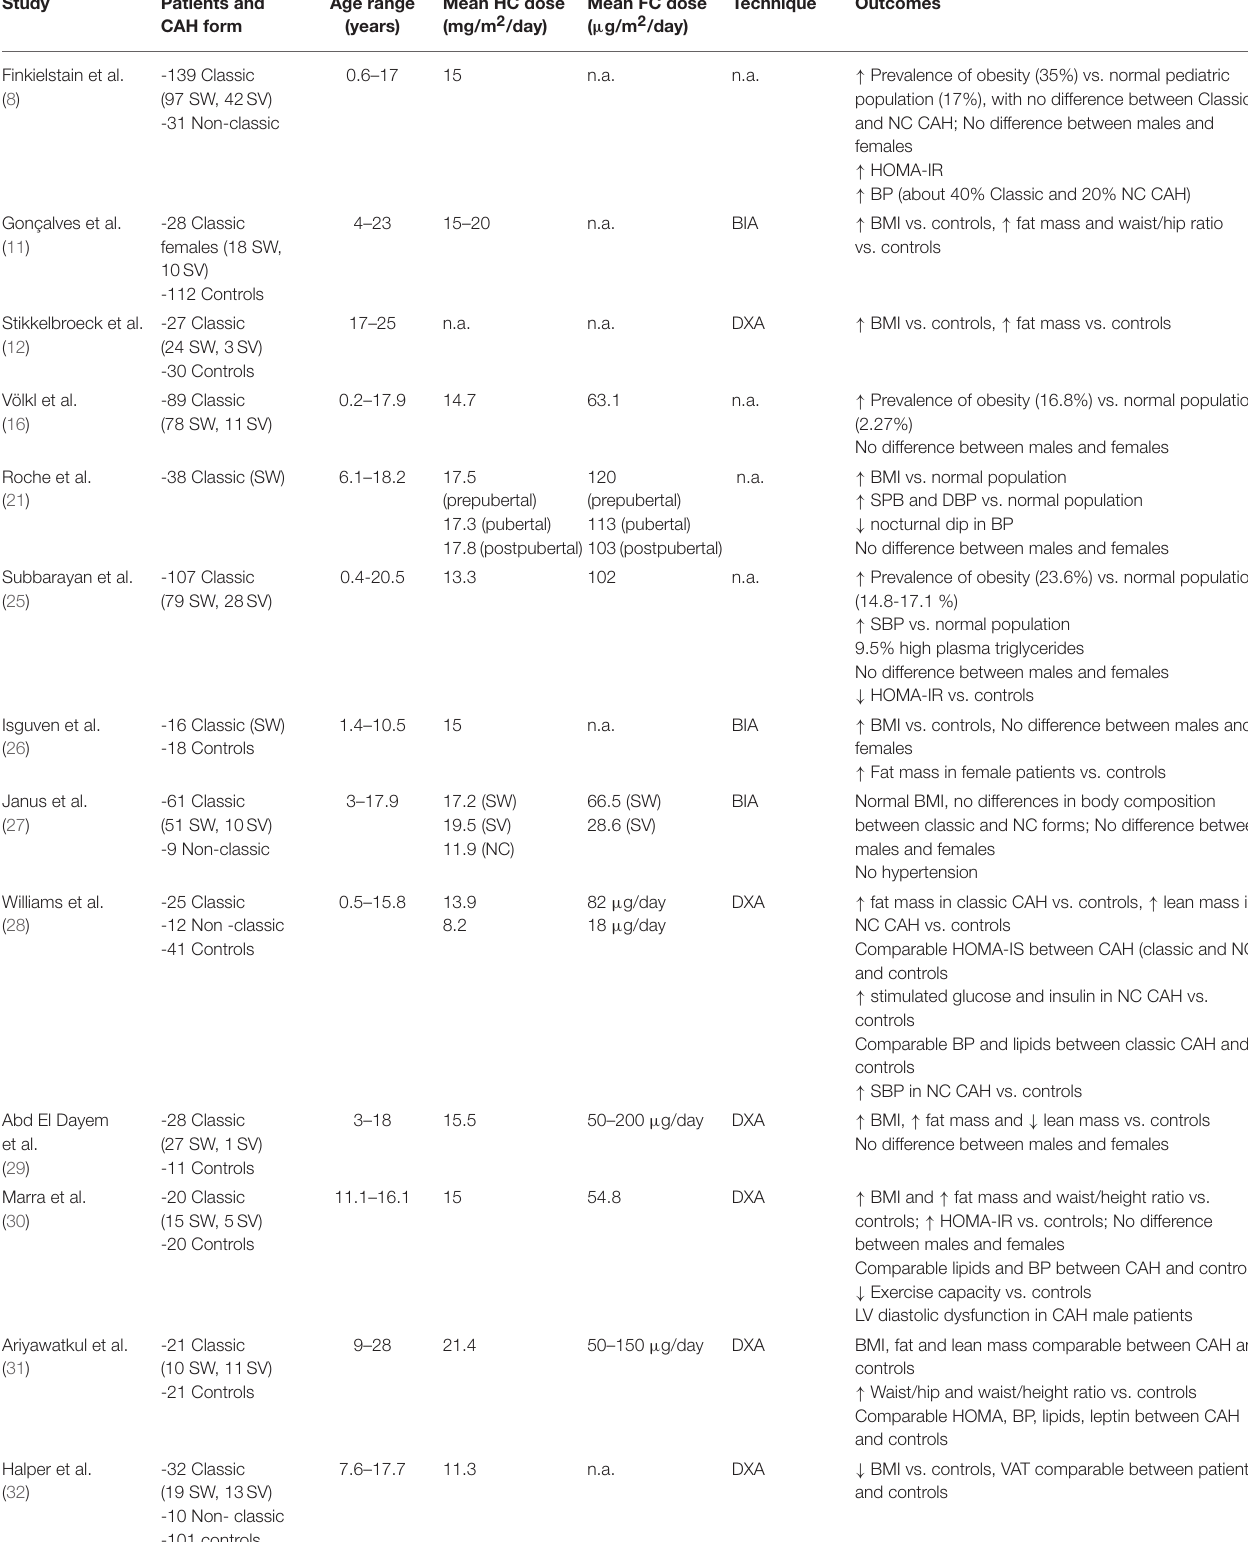
Technique Outcomes